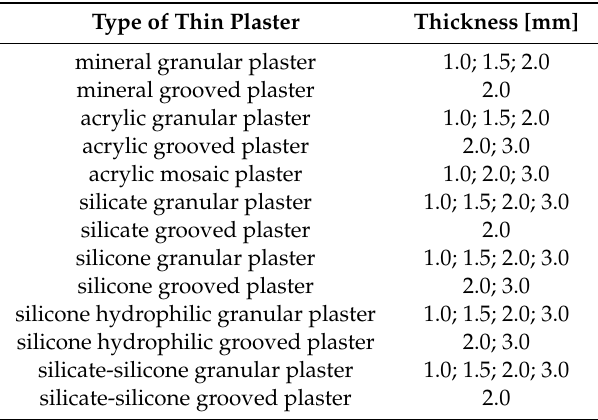
Table 3. List of thin plasters with potential thickness [46].